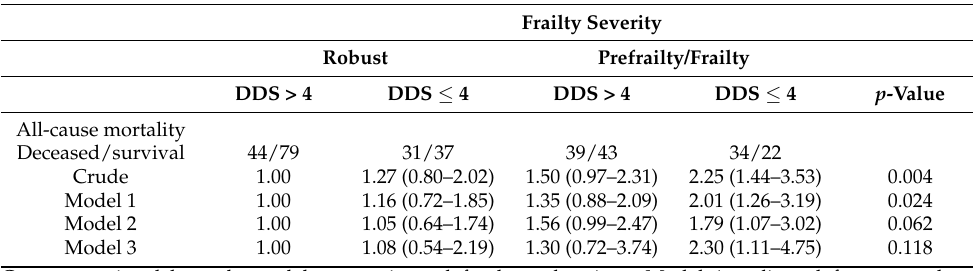
Table 3. Association between frailty status (combined prefrailty and frailty) stratified by DDS and all-cause mortality in 2005–2008 NAHSIT older adults (n =